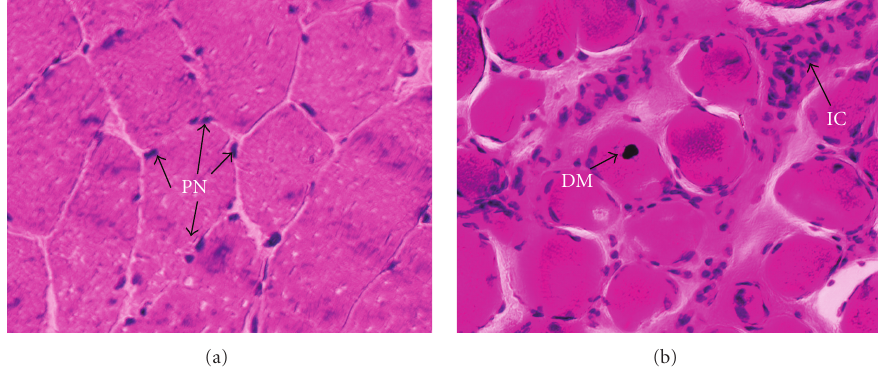
Figure 1: Histology of necrotic skeletal muscle. Image (a) showed a normal skeletal muscle from quadriceps muscle, characterized by healthy myofibres with peripheral nuclei (PN). Skeletal muscle of control subjects was obtained from males without dystrophinopathies at 40 years old. Image (b) showed a necrotic skeletal muscle from quadriceps muscle of a patient with DMD/DMB at five years old, characterized by infiltrating inflammatory cells (ICs) and degenerating myofibres (DMs). Transverse muscle sections stained with haematoxylin and eosin. Scale bar represents 50 m. This biopsy was obtained for the purpose of performing diagnostic.